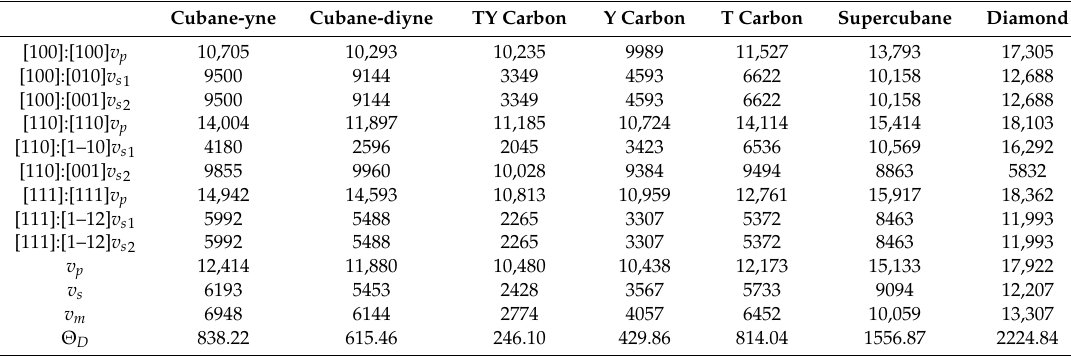
Table 3. The compressional sound wave velocity v s , shear sound wave velocity v p and mean sound wave velocity v m (m / s), and the Debye temperature (K) in the seven similar